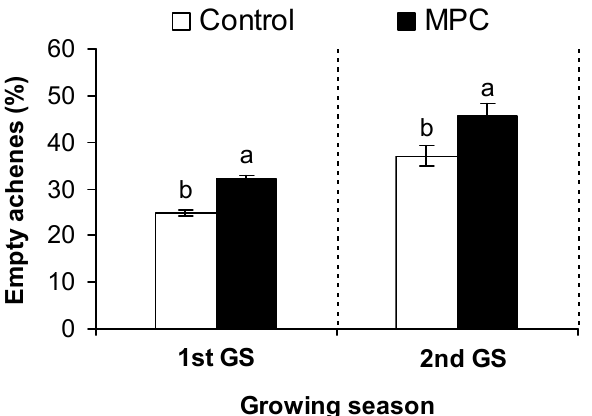
Figure 6. Percentage of empty achenes of sunflower plants as influenced by foliar treatments of MPC (37.5 + 37.5 g ha − 1 in the 1st growing season (GS) and 37.5 + 37.5 + 37.5 g ha − 1 in the 2nd GS). Different letters within each GS show statistically significant differences at p < 0.05 and vertical bars denote standard errors of means ( n = 12). MPC, mepiquat chloride.